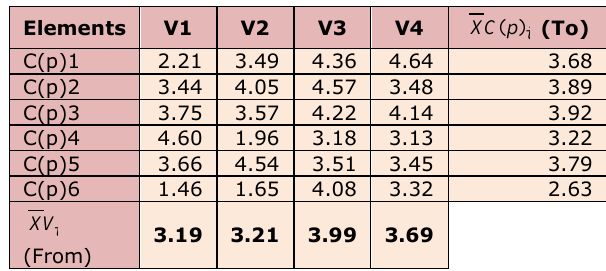
Table 4. Associations Matrix summary for the electronic tour guide design